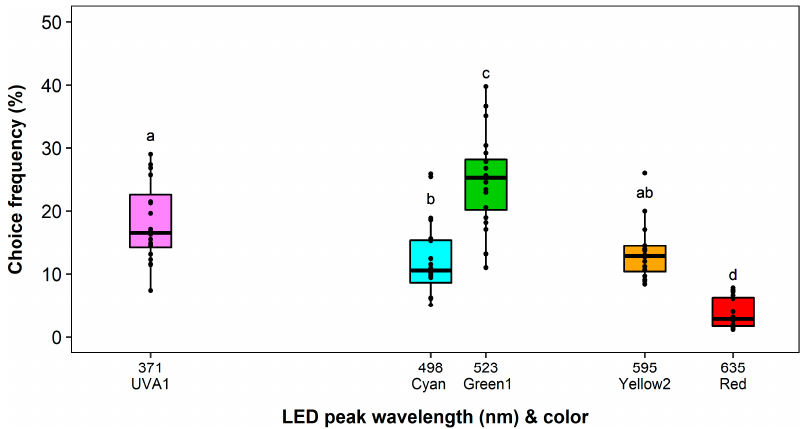
Figure 3. Wavelength preferences of Frankliniella occidentalis in multiple-choice experiment with light- emitting diodes (LEDs) in the complete spectral range of ultraviolet and visible light. See Table 1 and Figure 2 for LED color specifications. Significant differences are indicated by different letters (generalized linear model, Tukey test, p < 0.05, n = 20).